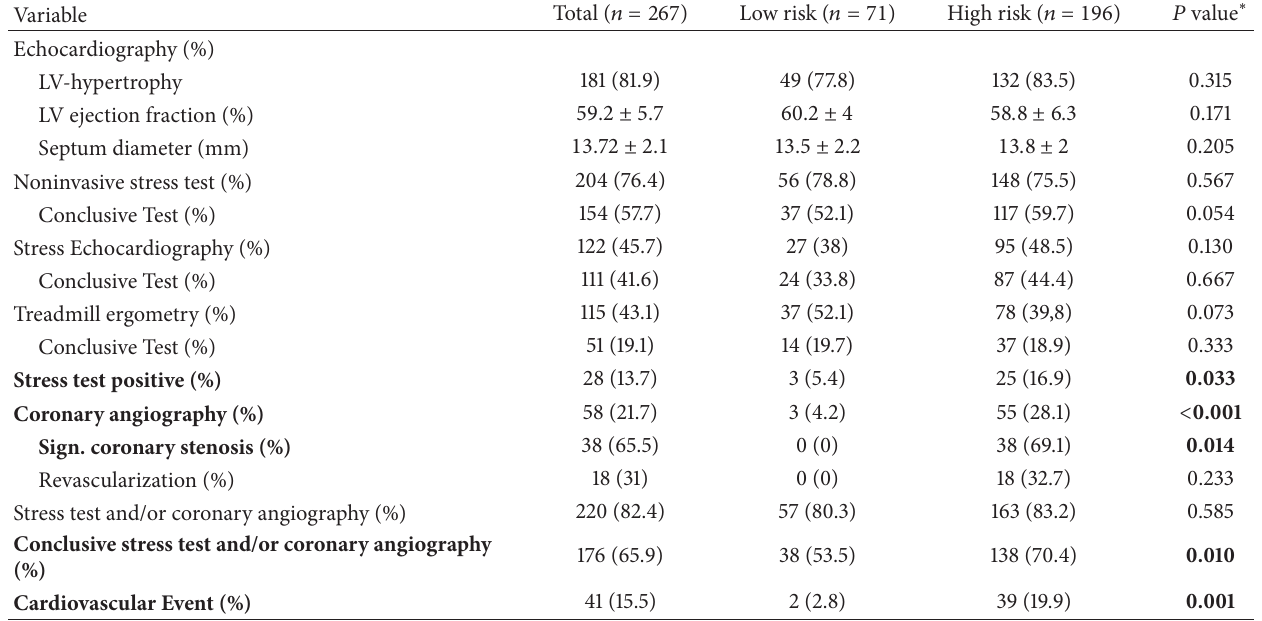
Table 2: Baseline cardiac screening procedures and subsequent MACE in renal transplant candidates stratified according to their risk status.